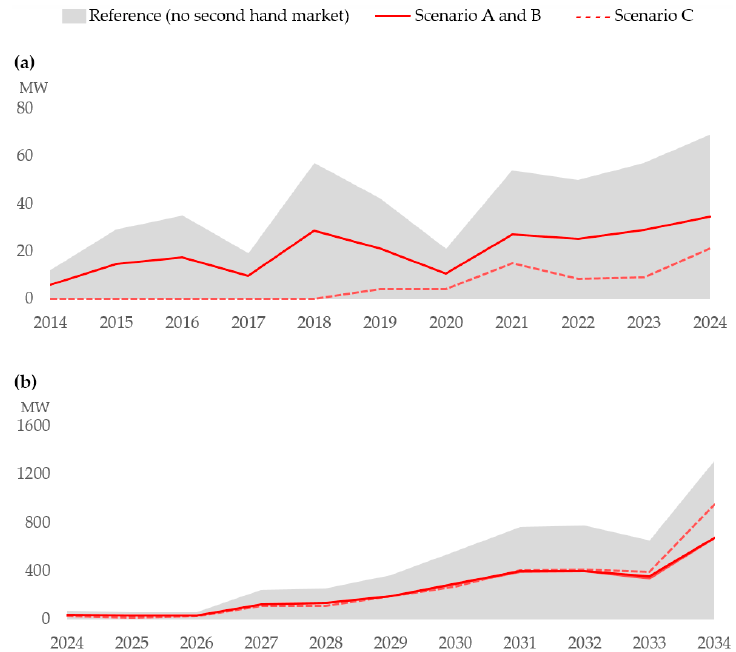
Figure 8. Calculated amount of total decommissioned power (grey area), and the amount of which that would turn into waste each year according to three different second hand scenarios (red lines): ( a ) Through 2014–2024; and ( b ) Through 2024–2034. As scenarios A and B are almost identical the difference between the two is presented as a red area.